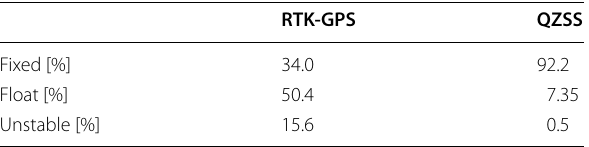
Table 3 Fixed, float, and unstable rates for the RTK‑GPS and the QZSS RTK‑GPS QZSS